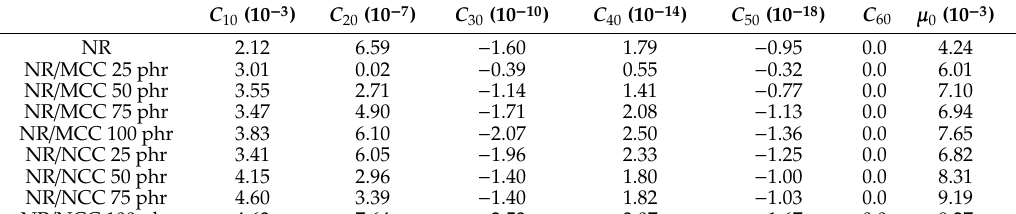
Figure 5. The stress–strain relationship from experiment data and hyperelastic modelling, 3rd to 6th order reduced polynomial. Table 2. Calibrated parameters of 6th order of reduced polynomial for the rubber composites.